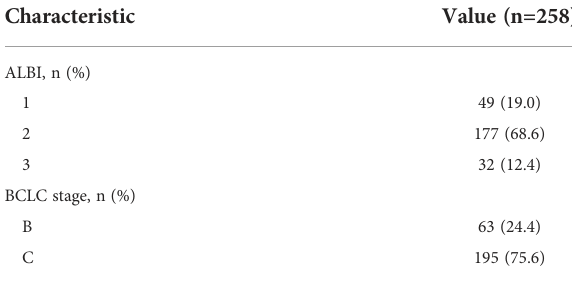
TABLE 1 Patient baseline